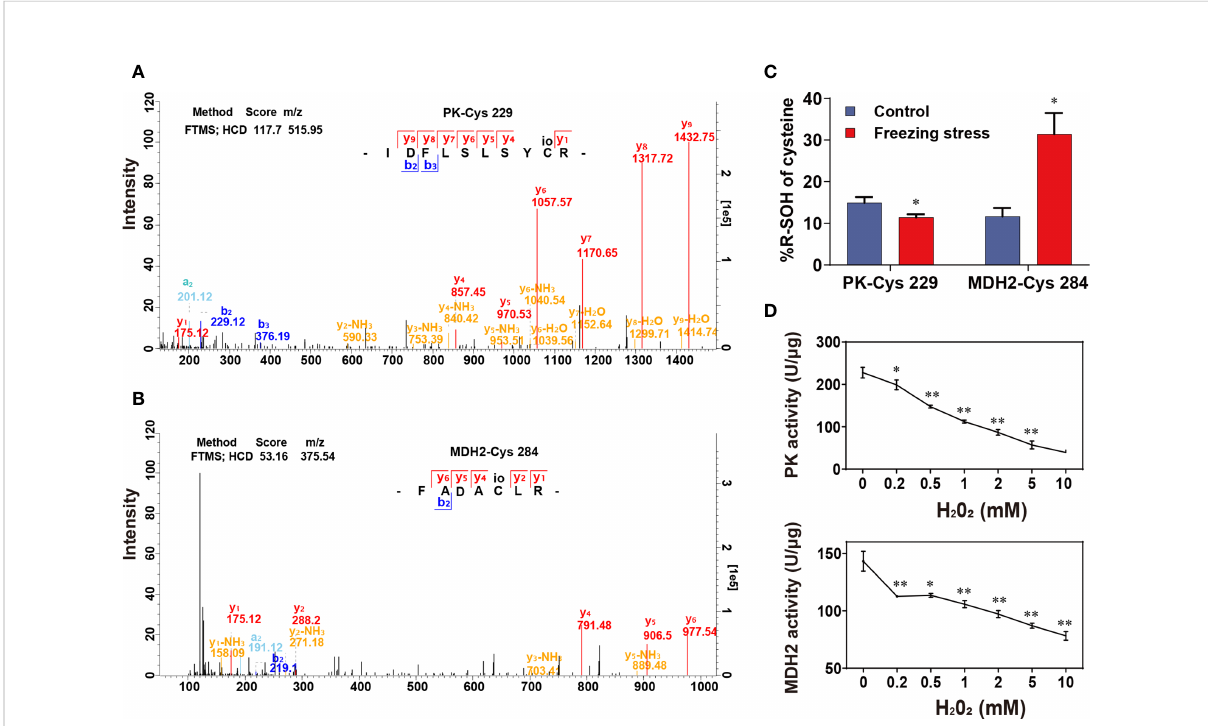
FIGURE 6 Effect of H 2 O 2 -induced sulfenylation on enzyme activity of pyruvate kinase (PK) and malate dehydrogenase 2 (MDH2). (A, B) Mass spectra of peptides containing PK-Cys 229 (A) and MDH2-Cys 284 (B) . The mass spectra scanning using fourier transform mass spectrometry (FTMS) and the fragmentation method is higher energy collision induced dissociation (HCD); Score, match degree between the fragment produced by the mass spectra and that recorded in the database; m/z, the ratio of mass to charge of the peptide; “ IDFLSLSYCR ” and “ FADACLR ” were the peptides sequence of PK and MDH2 identi fi ed in this study. (C) %R-SOH change of PK and MDH2. Values are means ± SD (n = 3 biological replicates, * P < 0.05 compared with control using Student ’ s t-test). (D) Enzyme activity of PK and MDH2 under H 2 O 2 treatment in vitro . Values are means ± SD (n = 3 technical replicates, * P < 0.05, ** P < 0.01 compared with control using Student ’ s